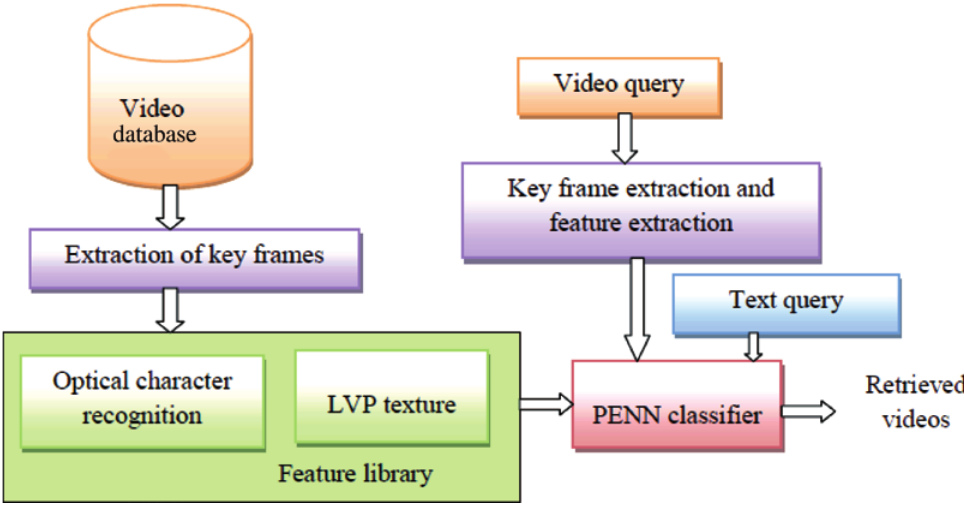
Figure 1: Block Diagram of the Proposed Video Retrieval